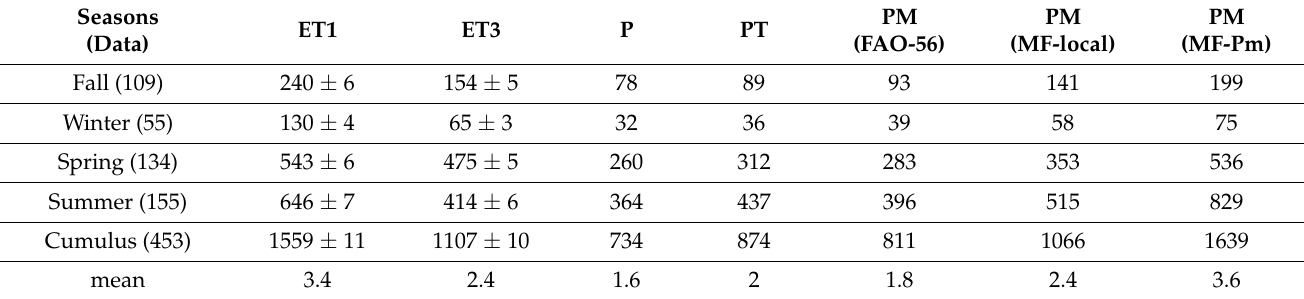
Table 8. Cumulatives and averages (in mm) evapotranspirations (ET) obtained with the lysimeters (ET1 and ET3) and the potential ET models. P, PT, PM (Fao-56), PM (MF-local.) are Penman, Priestley– Taylor, Fao-56, and M é t é o-France potential ETs evaluated with the local meteorological data while PM (MF-Pm) is the potential ET evaluated with the Paris-Montsouris station